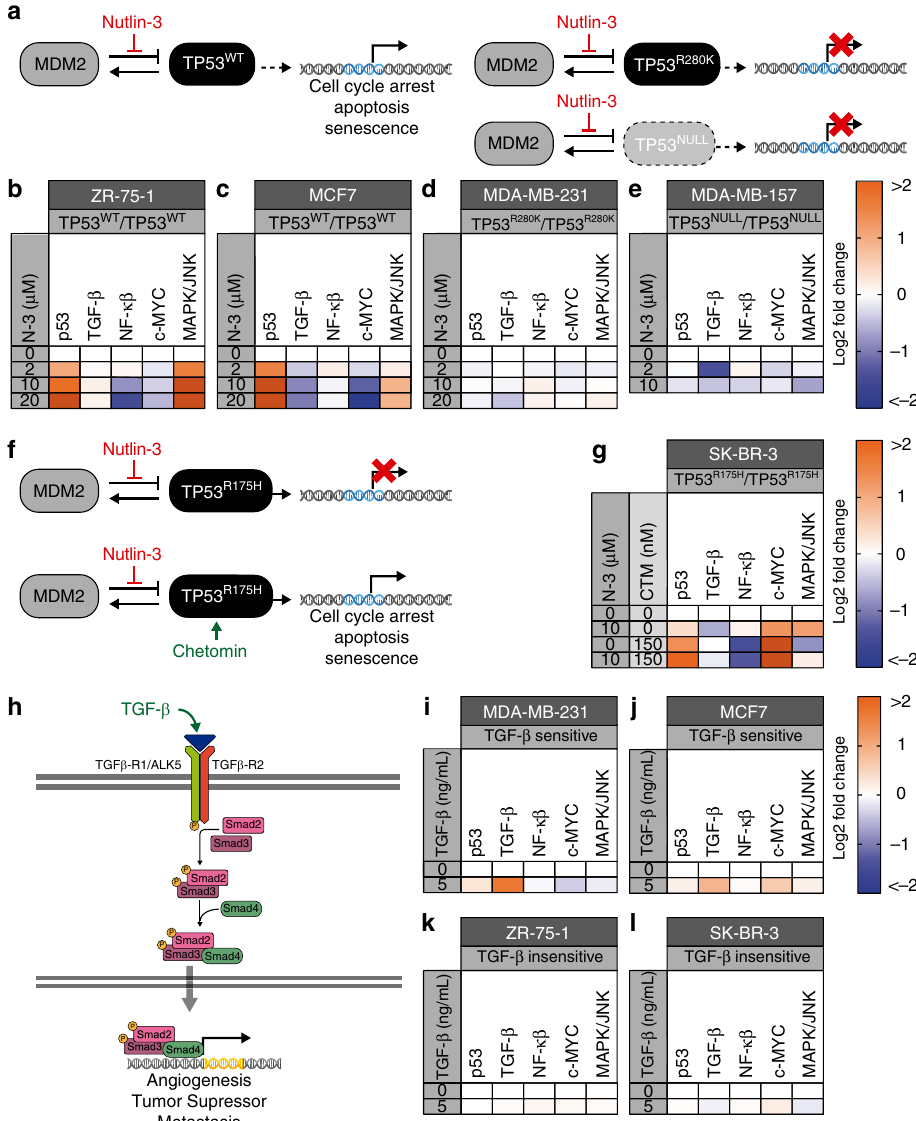
Fig. 6 Multiplex luciferase assaying simultaneously detects direct and collateral effects in breast cancer cell lines after treatment with pathway- speci fi c pharmaceuticals or ligands. a Schematic of p53 pathway activation induced by Nutlin-3. Nutlin-3 selectively inhibits the MDM2-TP53 interaction and activates the p53 pathway in a cell line that expresses wild-type TP53 (TP53 WT ). Cell lines that express mutant TP53 (TP53 R280K ) or are p53-de fi cient (TP53 NULL ) are resistant to Nutlin-3-induced activation of the p53 pathway. b – e Heat maps showing the effect of 24-hour treatment with increasing concentrations of Nutlin-3 (N-3) in four breast cancer cell lines: ZR-75-1 b and MCF7 c are WT, while MDA-MB-231 is mutant d , and MDA-MB-157 is null e . The p53 pathway is only activated in the two TP53 WT cell lines. Collateral and differential effects across the other pathways examined are shown. f Schematic of MDM2-p53 pathway reactivation by the pharmaceutical Chetomin. Cell lines that express R175H TP53 mutant protein (TP53 R175H ) are resistant to Nutlin-3-mediated inhibition of MDM2 and activation of the p53 pathway. In the presence of Chetomin, TP53 R175H is reactivated and functionally restored to WT-like levels. g Heat map demonstrating the complementary effect of Nutlin-3 and Chetomin on p53 signaling. SK-BR-3 cells were not signi fi cantly affected by Nutlin-3. The addition of 150 nM of Chetomin reactivates the p53 pathway in the presence and absence of Nutlin-3. Collateral and differential effects on the other pathways are shown for all treatments. h Schematic of TGF- β pathway activation by TGF- β ligand. TGF- β activates cellular signaling through the heterodimeric receptor TGF- β -R1/ALK5 and TGF- β -R2, resulting in transcriptional activation of downstream genes mediated by Smad2/Smad3/Smad4. i – l Effect of a 6-h treatment with 5 ng/mL of recombinant TGF- β in four breast cancer cell lines: MDA-MB-231 i , MCF7 j , ZR-75-1 k , and SK-BR-3 l . Addition of the ligand resulted in signi fi cant activation of the downstream luciferase reporter in TGF- β -sensitive lines (MDA-MB-231 and MCF7). Signi fi cant downregulation of the c-Myc pathway was also observed in these cell lines. The addition of the ligand did not result in signi fi cant pathway activation in TGF- β -insensitive cell lines (ZR-75-1 and SK-BR-3). n = 4 for all multiplex luciferase experiments. Source data are provided as a Source Data fi